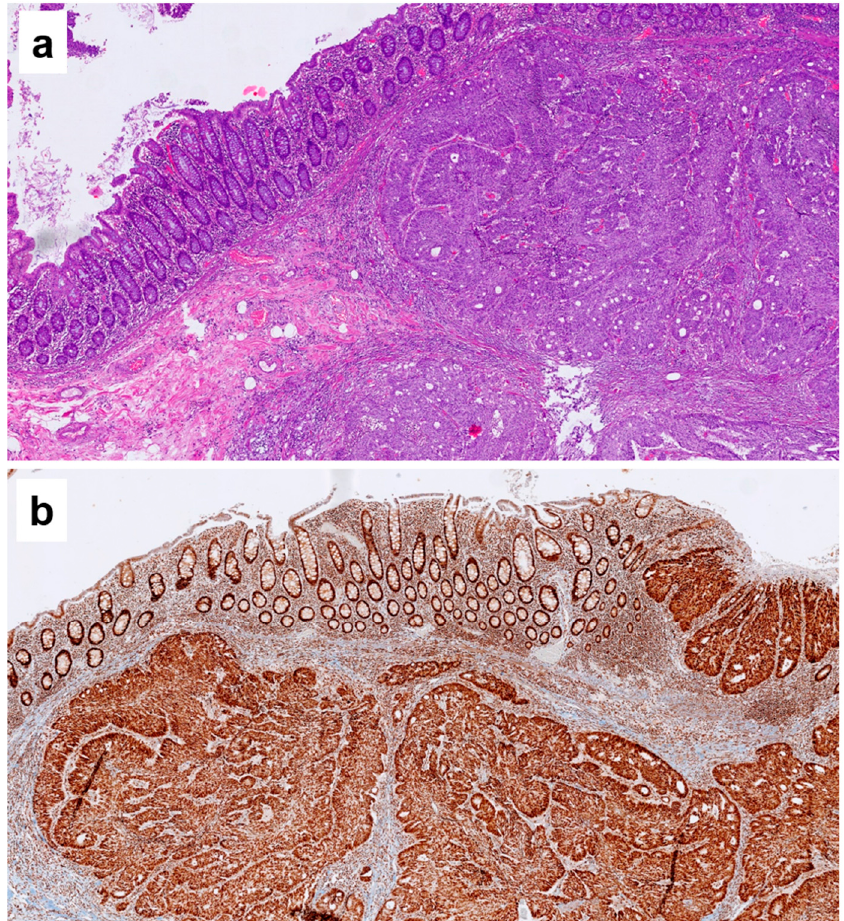
Figure 8. Immuno-histochemical analysis. ( a ) Solid cancer tumor in relation to normal glandular mucosa and corresponding to the area where fibers were observed (magnification 4×). ( b ) IHC staining for MLH1 of the same area. Brown color indicates expression of the MLH1 nuclear protein. High expression in tumor cells indicates well-functioning mismatch repair protein complex.